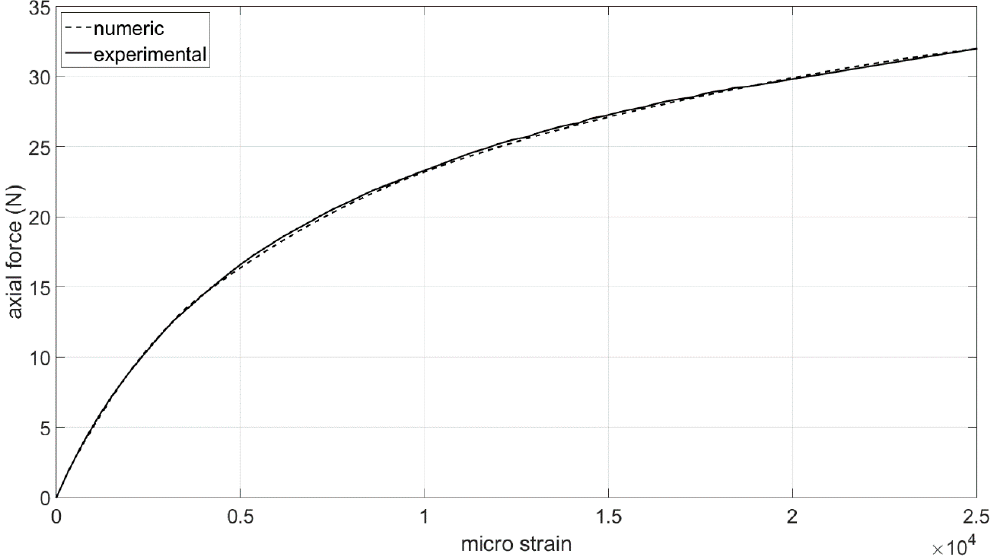
Figure 14. Experimental setup for laboratory tests [30].